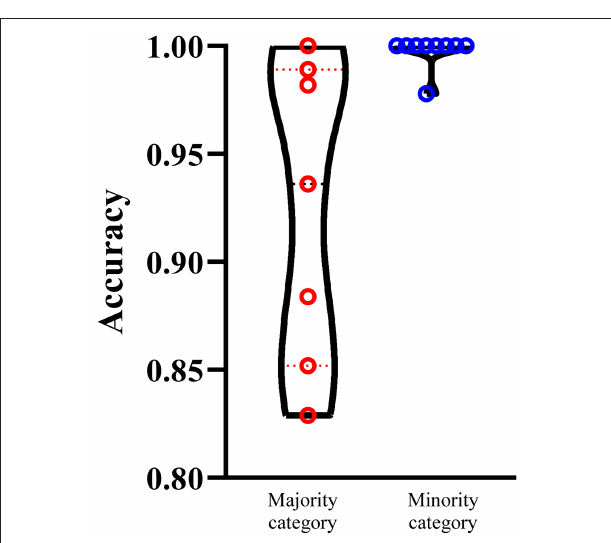
FIGURE 5 | Performance of the optimum RF classifiers on majority and minority categories using the combined functional and network embeddings. The majority categories contain more than 100 proteins, whereas the minority categories consist of < 100 proteins. The performance on minority categories is not lower than that on the majority